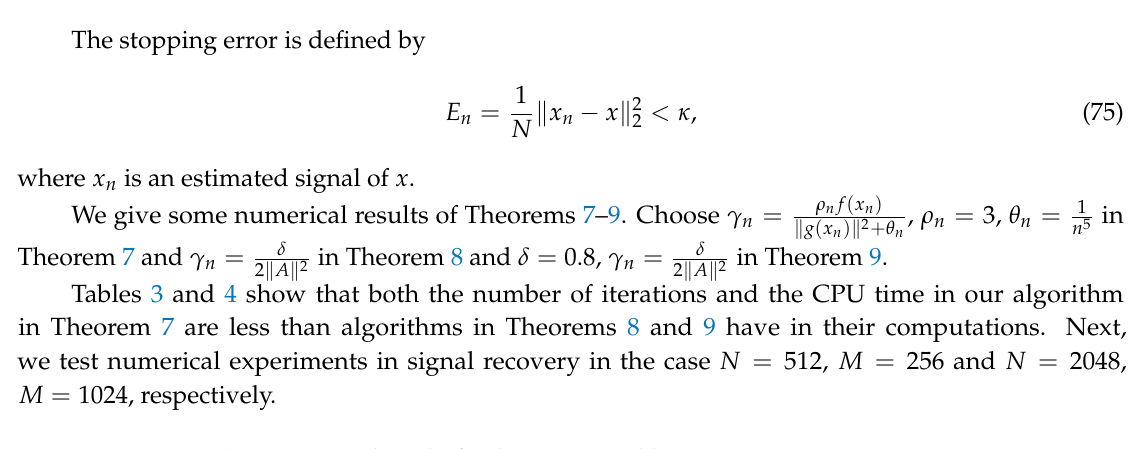
Table 3. Numerical results for the LASSO problem in case M = 256, N = 512. m -Sparse